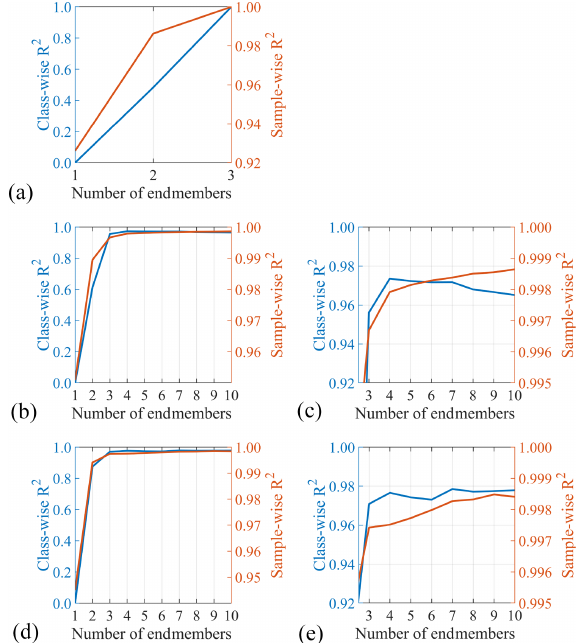
Earth Surf. Dynam., 8, 527–553, 2020